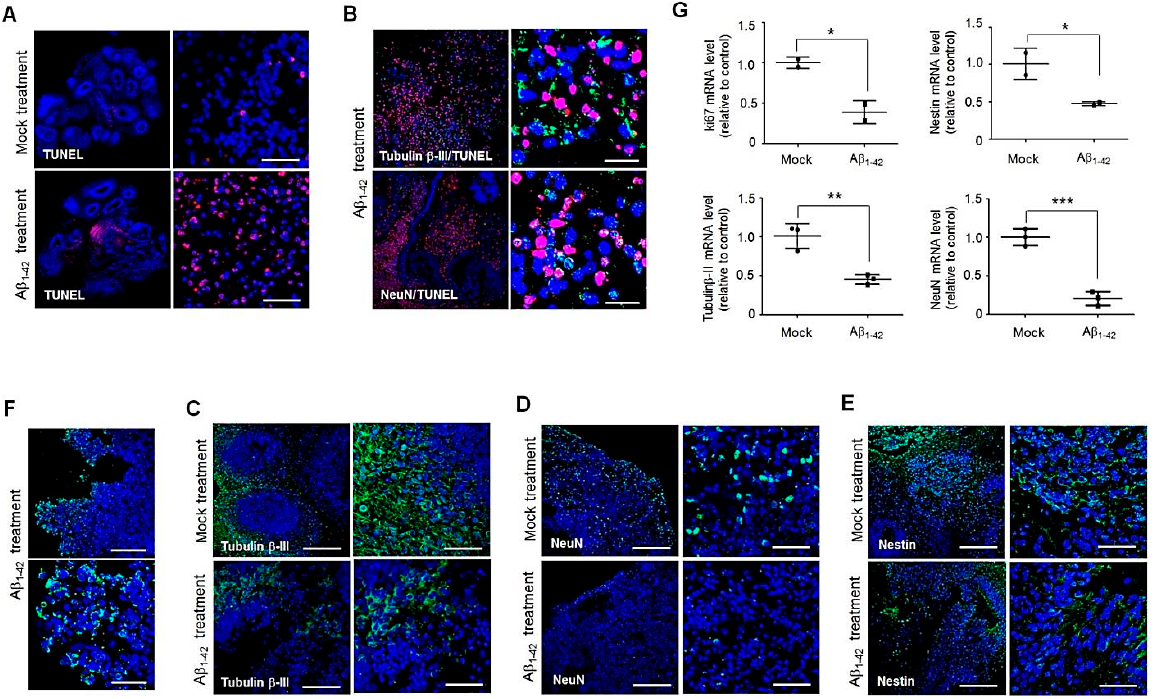
Figure 2. Histological analysis of hBOs cultured in the presence of A β 1–42 . ( A – E ) The hBOs were cultured in the absence or presence of 10 μ M A β 1–42 for 72–80 h. Confocal microscopy images of hBOs after staining OCT-embedded sections with a TUNEL assay kit (red) or with antibodies against tubulin β -III tubulin, NeuN, and Nestin (green). Nuclei were labeled with DAPI (blue). Scale bars: 50 μ m, 20 μ m, or 200 μ m. ( F ) Confocal microscopy images of hBOs cultured in the presence of 10 μ M A β 1–42 after staining of OCT- embedded sections with an antibody against 6E10 to detect A β deposition (green). Nuclei were labeled with DAPI (blue). Scale bars: 200 μ m or 50 μ m. ( G ) Ki67, Tubulin β -III tubulin, Nestin, and NeuN mRNA levels were measured at 72–80 h after culture by quan- titative real-time PCR in hBOs cultured with or without A β 1–42 . The GAPDH gene was used as a control. The values shown are the mean (SD). The significance of differences between two different samples was determined with Student’s t-test. * p < 0.05, ** p < 0.01, *** p < 0.001. All data are representative of two or three independent experiments.